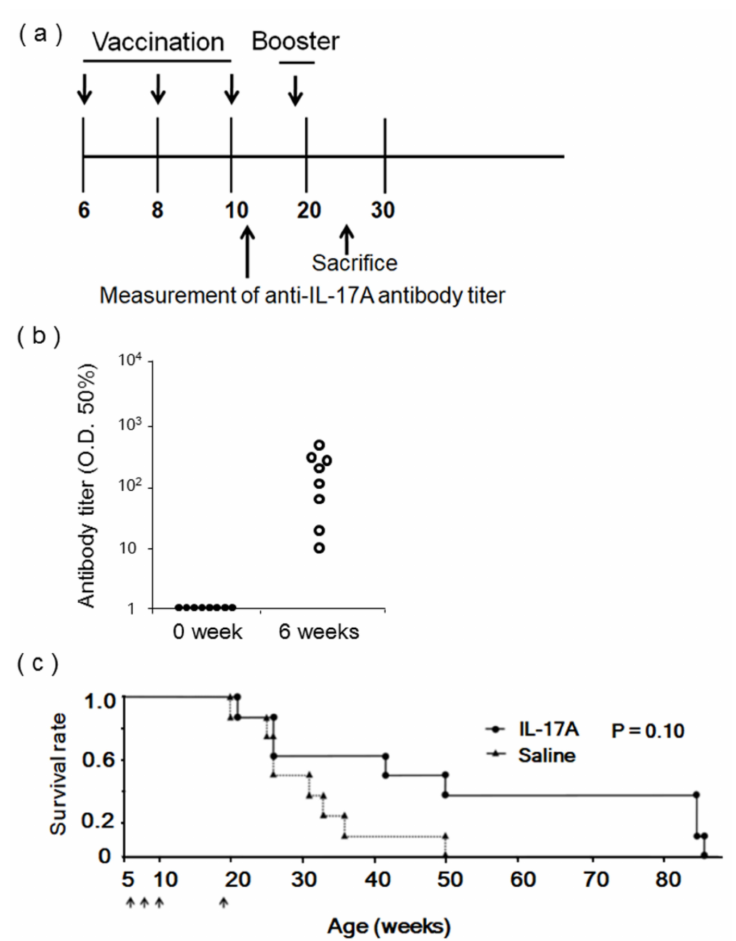
Figure 5. Effects of IL-17A DNA vaccine in MRL / lpr mice; ( a ) Female MRL / lpr mice were immunized with pcDNA3.1-HBc-IL17A1 (IL-17A1) or saline via intramuscular administration using an electroporator three times at 2-week intervals. Booster immunization was performed 13 weeks after three vaccinations. Antibody titers of vaccinated MRL / lpr mice were measured 6 weeks after first vaccination (12 weeks old), and mice were sacrificed 18 weeks after first vaccination (24 weeks old). ( b ) Antibody titers from vaccinated 12-week-old MRL / lpr mice were measured ( n = 8). ( c ) Time course of IL-17A DNA vaccination for survival experiments. Kaplan–Meier curve of time to survival rate, log rank p = 0.10 between HBc-IL-17A group and nonimmunization group (saline). The arrows indicate vaccination. ( • ): IL-17A vaccine group ( n = 6); ( (cid:78) ): saline group ( n = 8); The arrows indicate the intramuscular administration of Il-17A vaccine or Saline using an